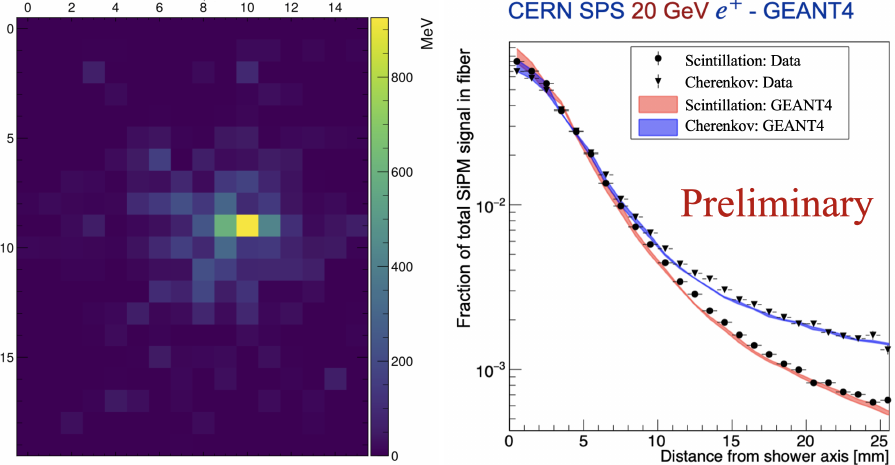
Figure 7. Event display for a 6 GeV electron depositing the energy in the highly granular module (( left ) panel). The colour in each box is proportional to the signal recorded by one SiPM after being calibrated in energy. The ( right ) plot shows the lateral profile of showers produced by 20 GeV electrons in the calorimeter read out by SiPMs and measured separately with the scintillating and Cherenkov signals. The test beam data are compared to the results obtained with a Monte Carlo simulation that describes the experimental setup used at